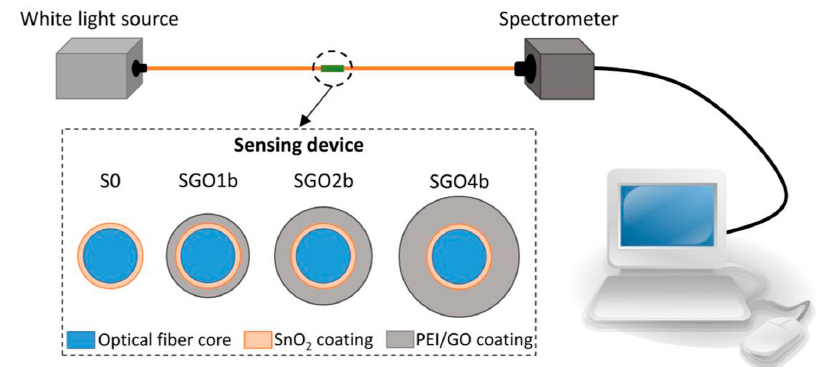
Figure 8. Ethanol sensing experimental setup using SnO 2 / PEI / GO coated fiber [119]. Copyright © 2018,